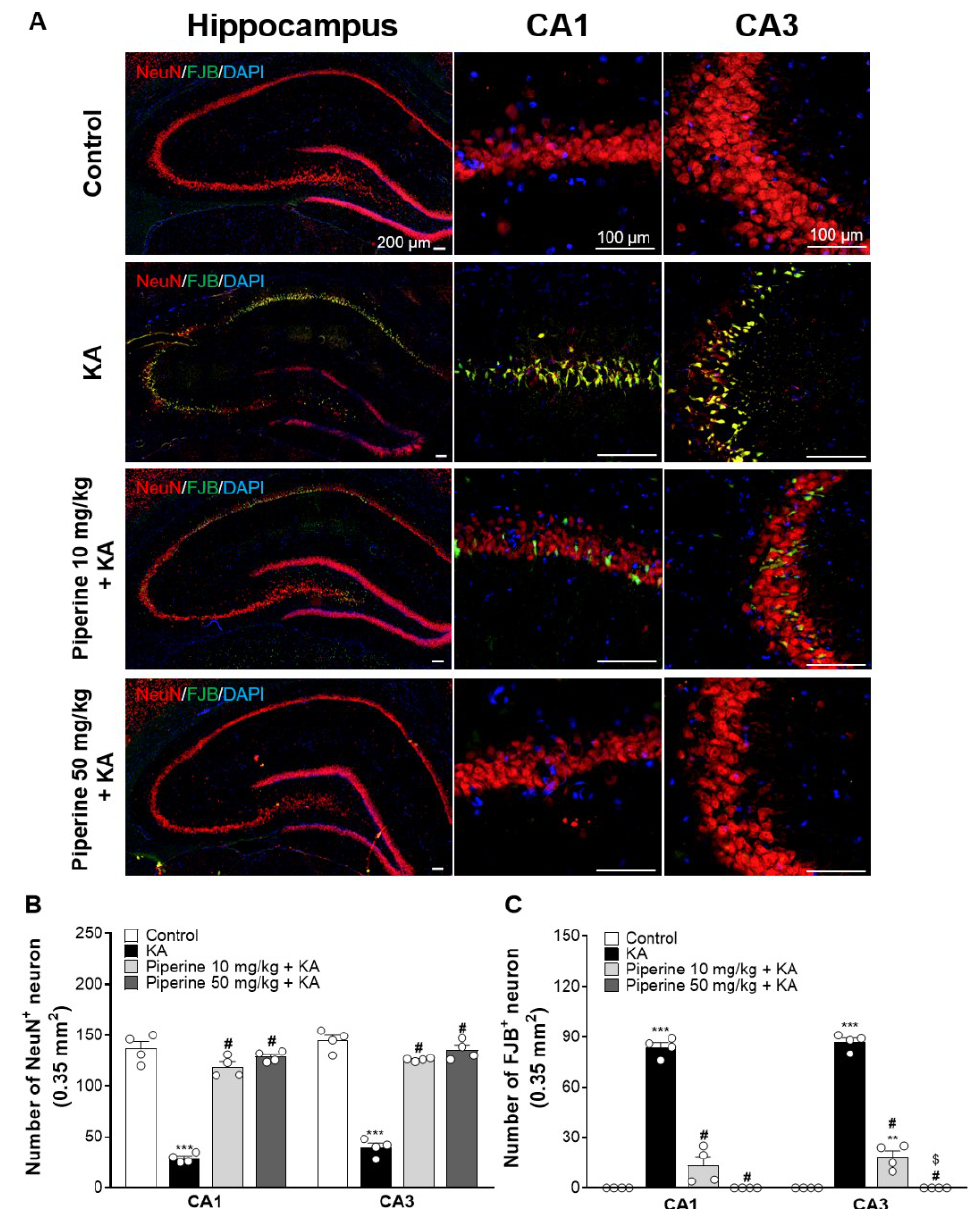
Figure 4. Effect of piperine pretreatment on neuronal damage in the hippocampus of KA-treated rats. ( A ) CA1 and CA3 regions of the hippocampus are observed with NeuN, FJB, and DAPI immunofluorescent staining. Scar bar for hippocampus = 200 µ m; scar bar for CA1 and CA3 regions = 100 µ m. ( B , C ) Quantitative analysis of NeuN-positive and FJB-positive neurons in the hippocampal CA1 and CA3 regions. Data are presented as the means ± S.E.M. (n = 4). # p < 0.001 versus the KA group; ** p < 0.01 versus the control group; *** p < 0.001 versus the control group; $ p < 0.01 versus the KA + piperine 10 mg/kg group (ANOVA/Scheffé).